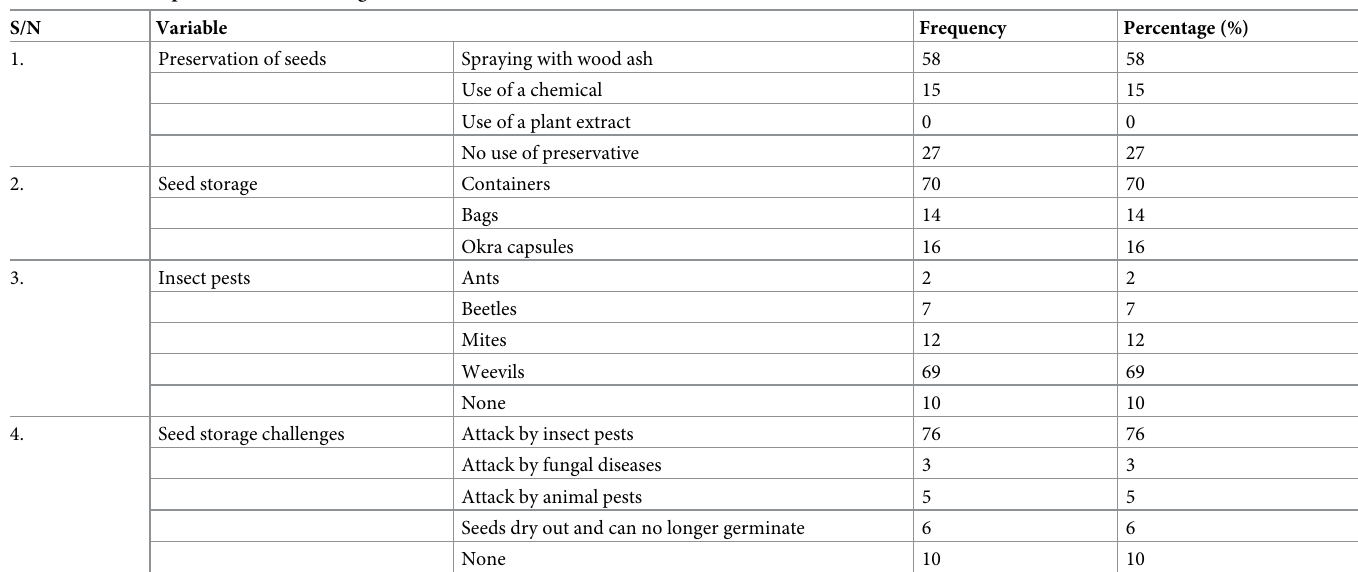
Table 4. Okra seed preservation and storage.